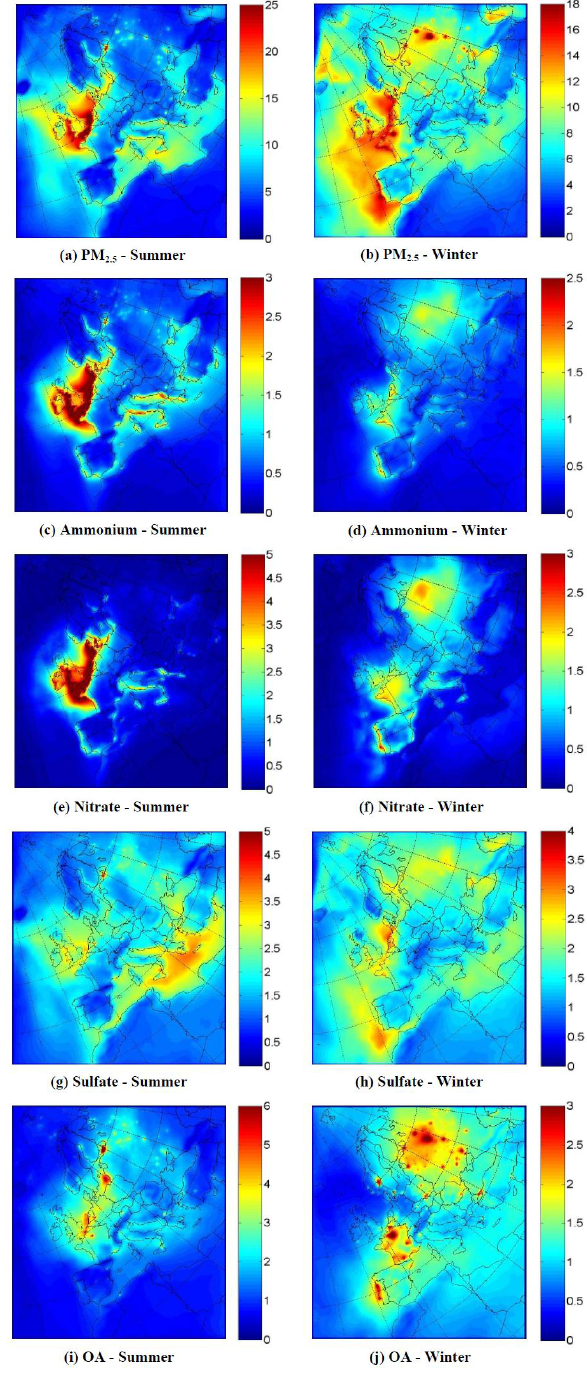
Fig. 2. Predicted base case ground-level concentrations (µgm − 3 ) of (a–b) PM 2 . 5 , (c–d) ammonium, (e–f) nitrate, (g–h) sulfate, and Figure 2. Predicted base case ground-level concentrations (μg m -3 ) of (a-b) PM 2.5 , (c-d) 3 (i–j) total OA, during the modeled summer and the modeled winter ammonium, (e-f) nitrate, (g-h) sulfate, and (i-j) total OA, during the modeled summer and the 4 period. Different concentration scales are used for each modeled winter period. Different concentration scales are used for each graph. 5